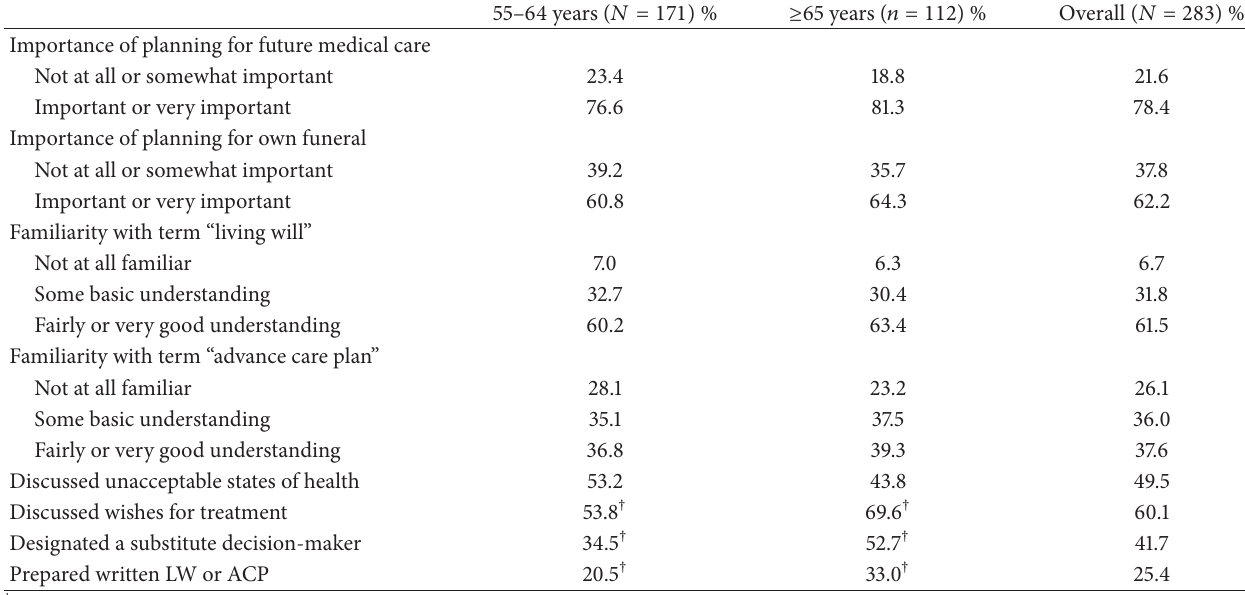
Table 2: Values, knowledge, and behaviors related to planning for the end of